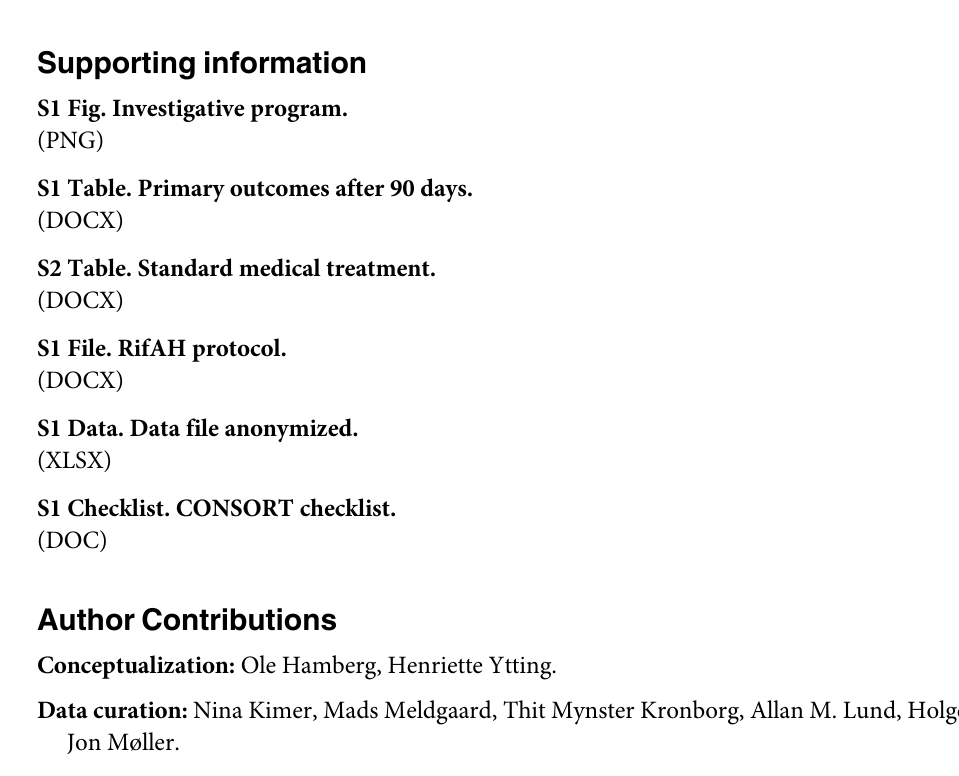
S2 Table. Standard medical